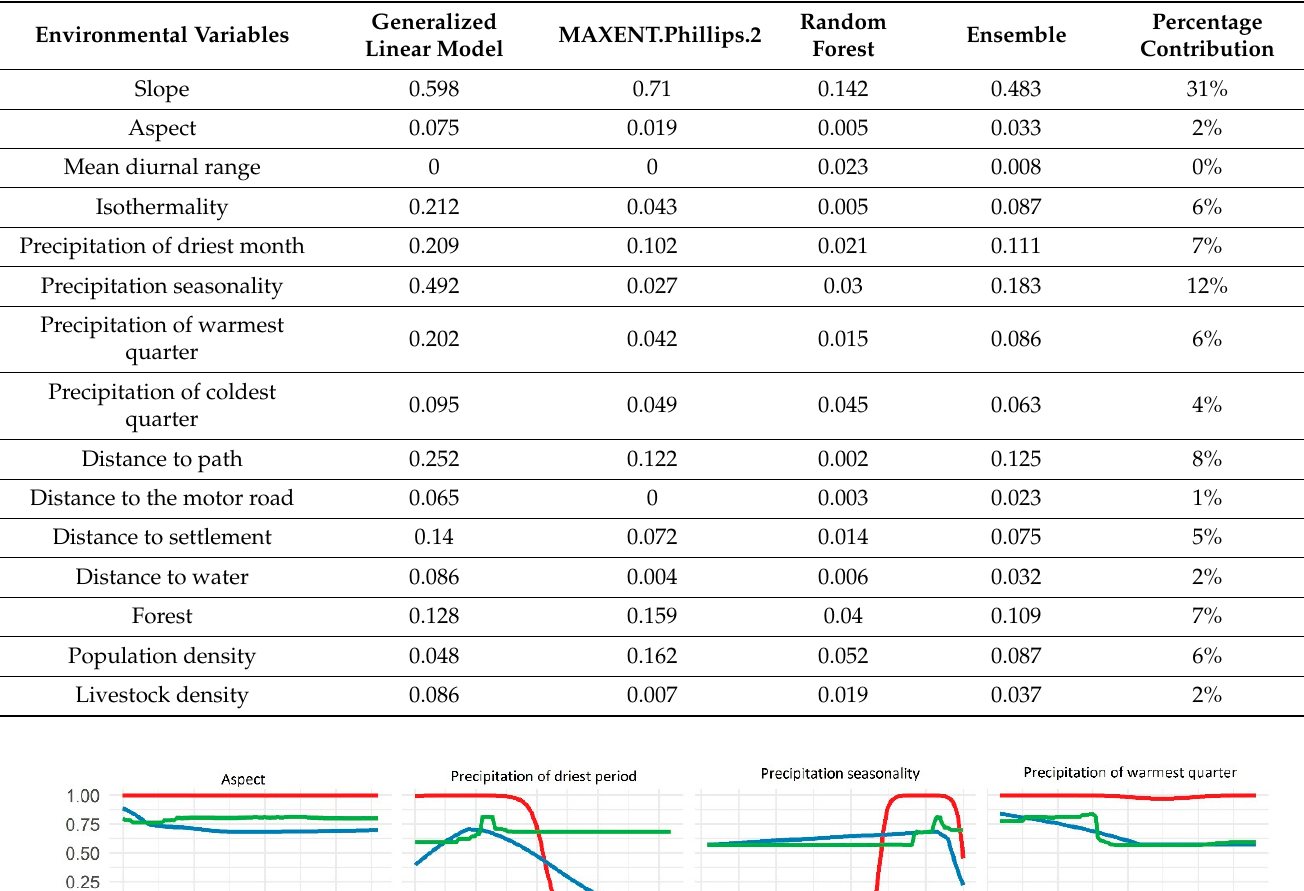
Table 3. Percentage contributions of environmental variables to the model.